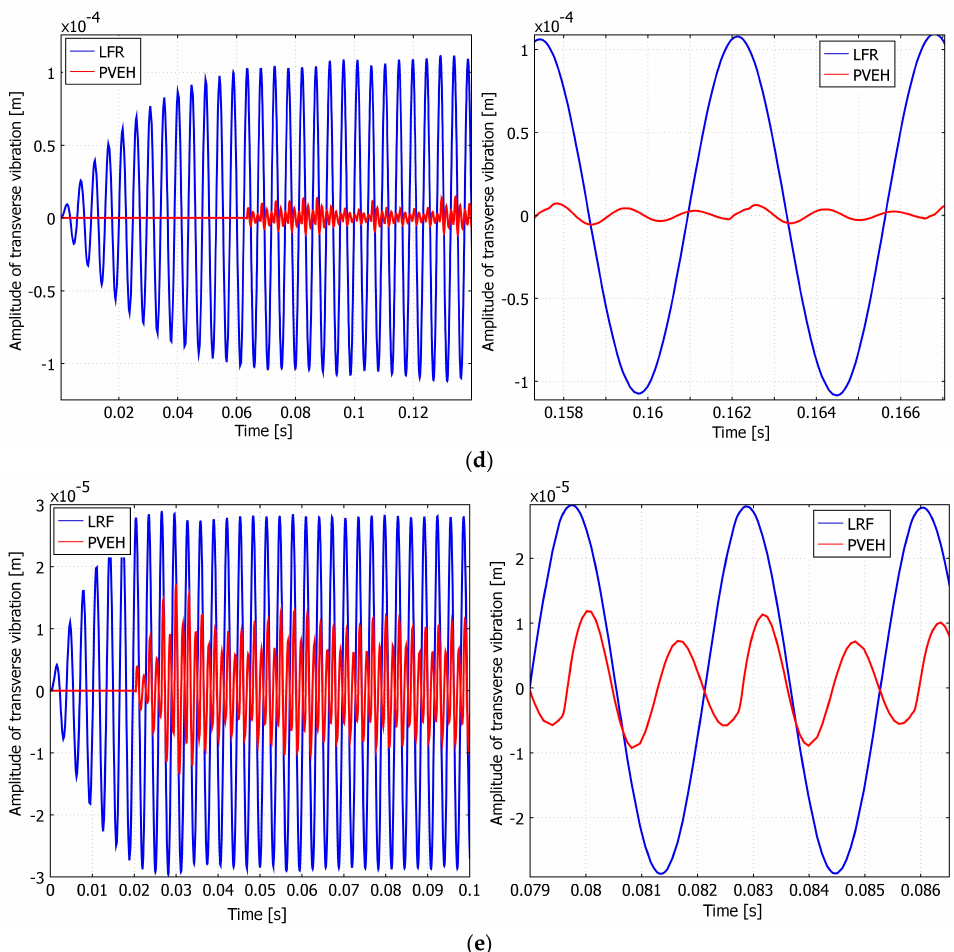
Figure 3. Transverse vibrations of LFR (blue) and high frequency PVEH (red) tip point. Contact position (cid:1838) (cid:3010)(cid:3041) = 0.5 L of PVEH and natural frequency ratio (cid:2033) (cid:2869)(cid:3017)(cid:3023)(cid:3006)(cid:3009) /(cid:2033) (cid:2869)(cid:3013)(cid:3007)(cid:3019) = ( a ) 8; ( b ) 6; ( c ) 4; ( d ) 3; ( e ) 2.